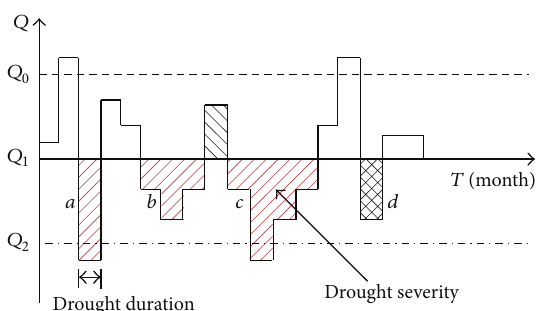
Figure 2: Diagram of drought identification using the theory of